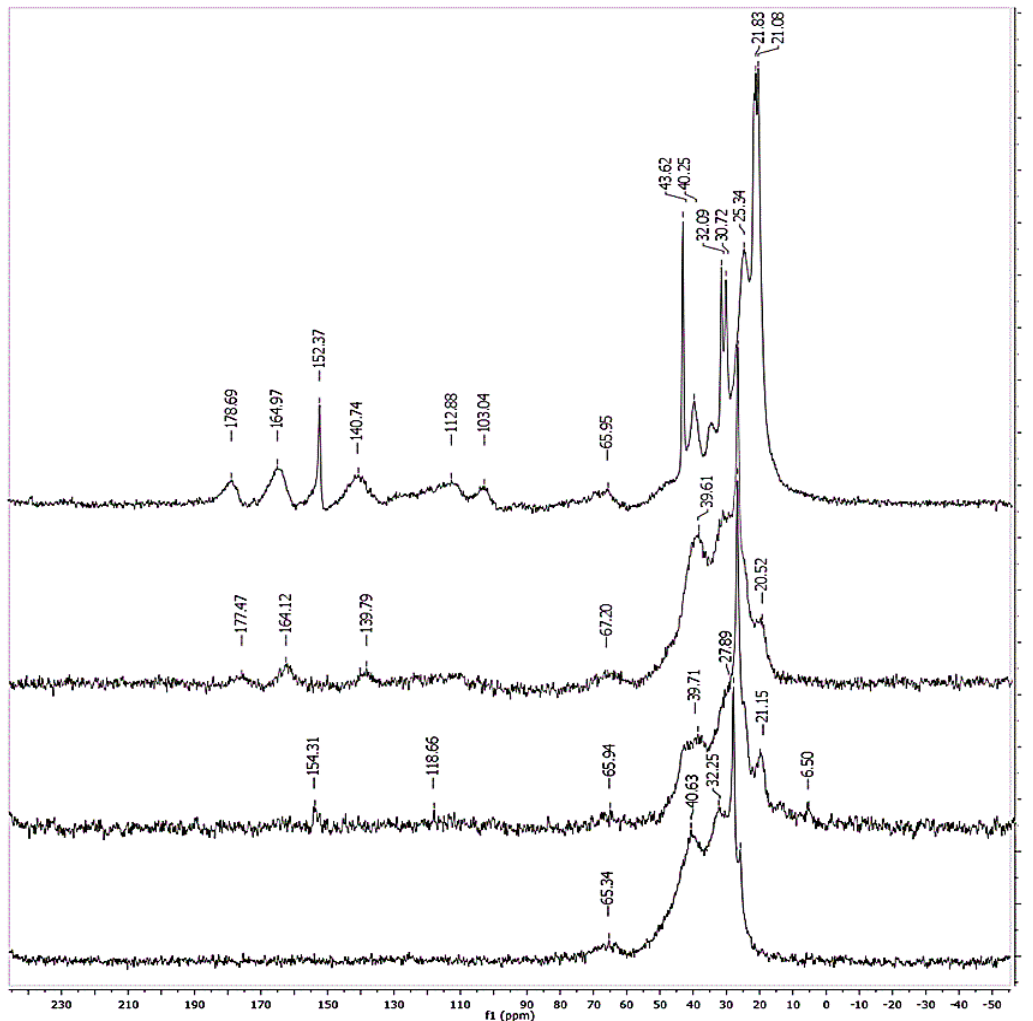
Figure 5. 13 C CP-MAS NMR of NDs: ( a ) Unfunctionalized, ( b ) ND-SQ1, ( c ) ND-SQ2, and ( d ) ND-SQ3.